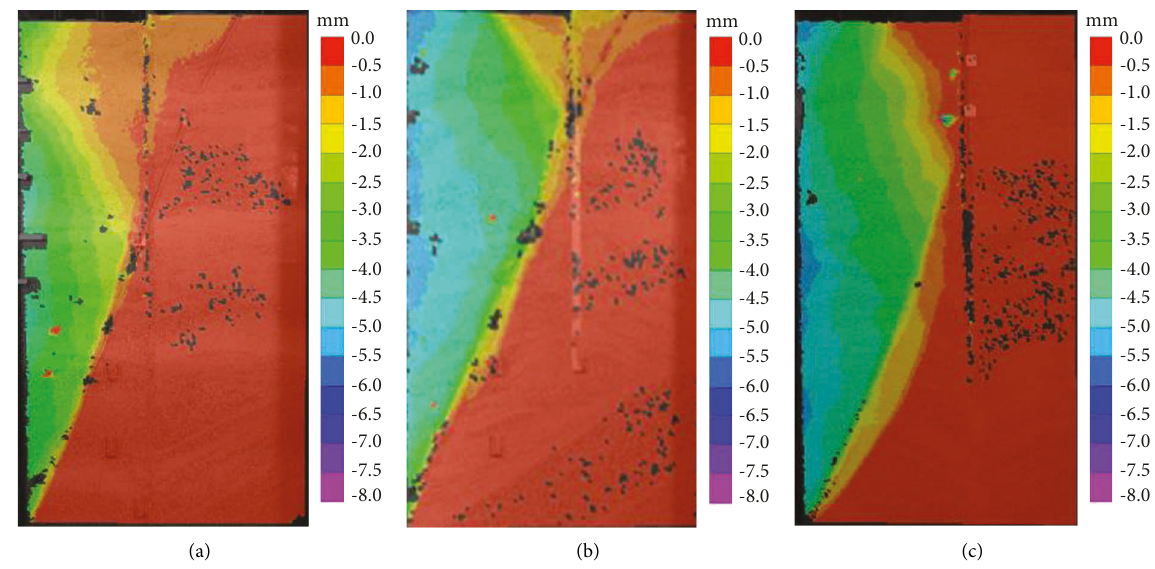
Figure 14: The horizontal displacement field in samples (a) M4, (b) M5, and (c) M6.